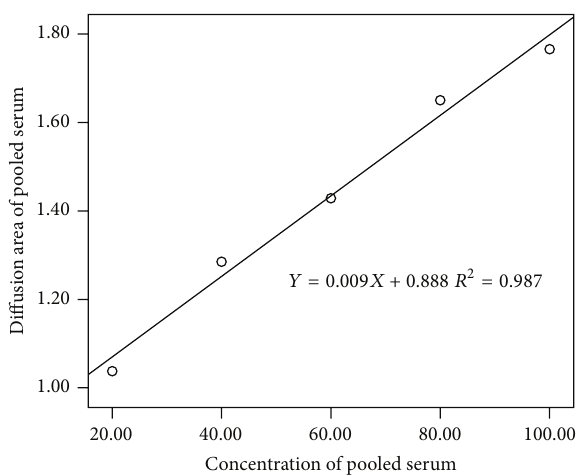
Figure 3: Linear experiment of pooled serum in 0.003 mol/L KMnO 4 .